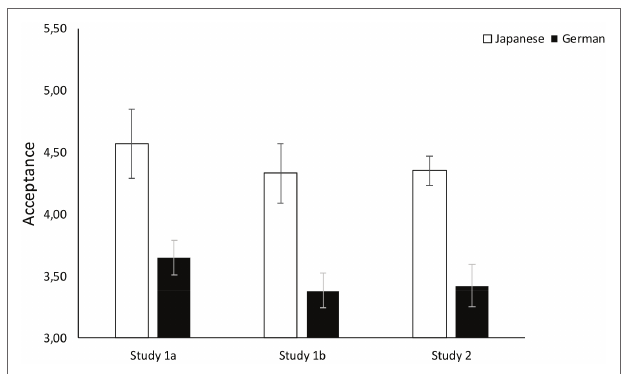
FIGURE 2 | Cultural differences in personal choice demand as a reaction to vicarious choice in Studies 1a, 1b, and 2. Error bars show 95% confidence